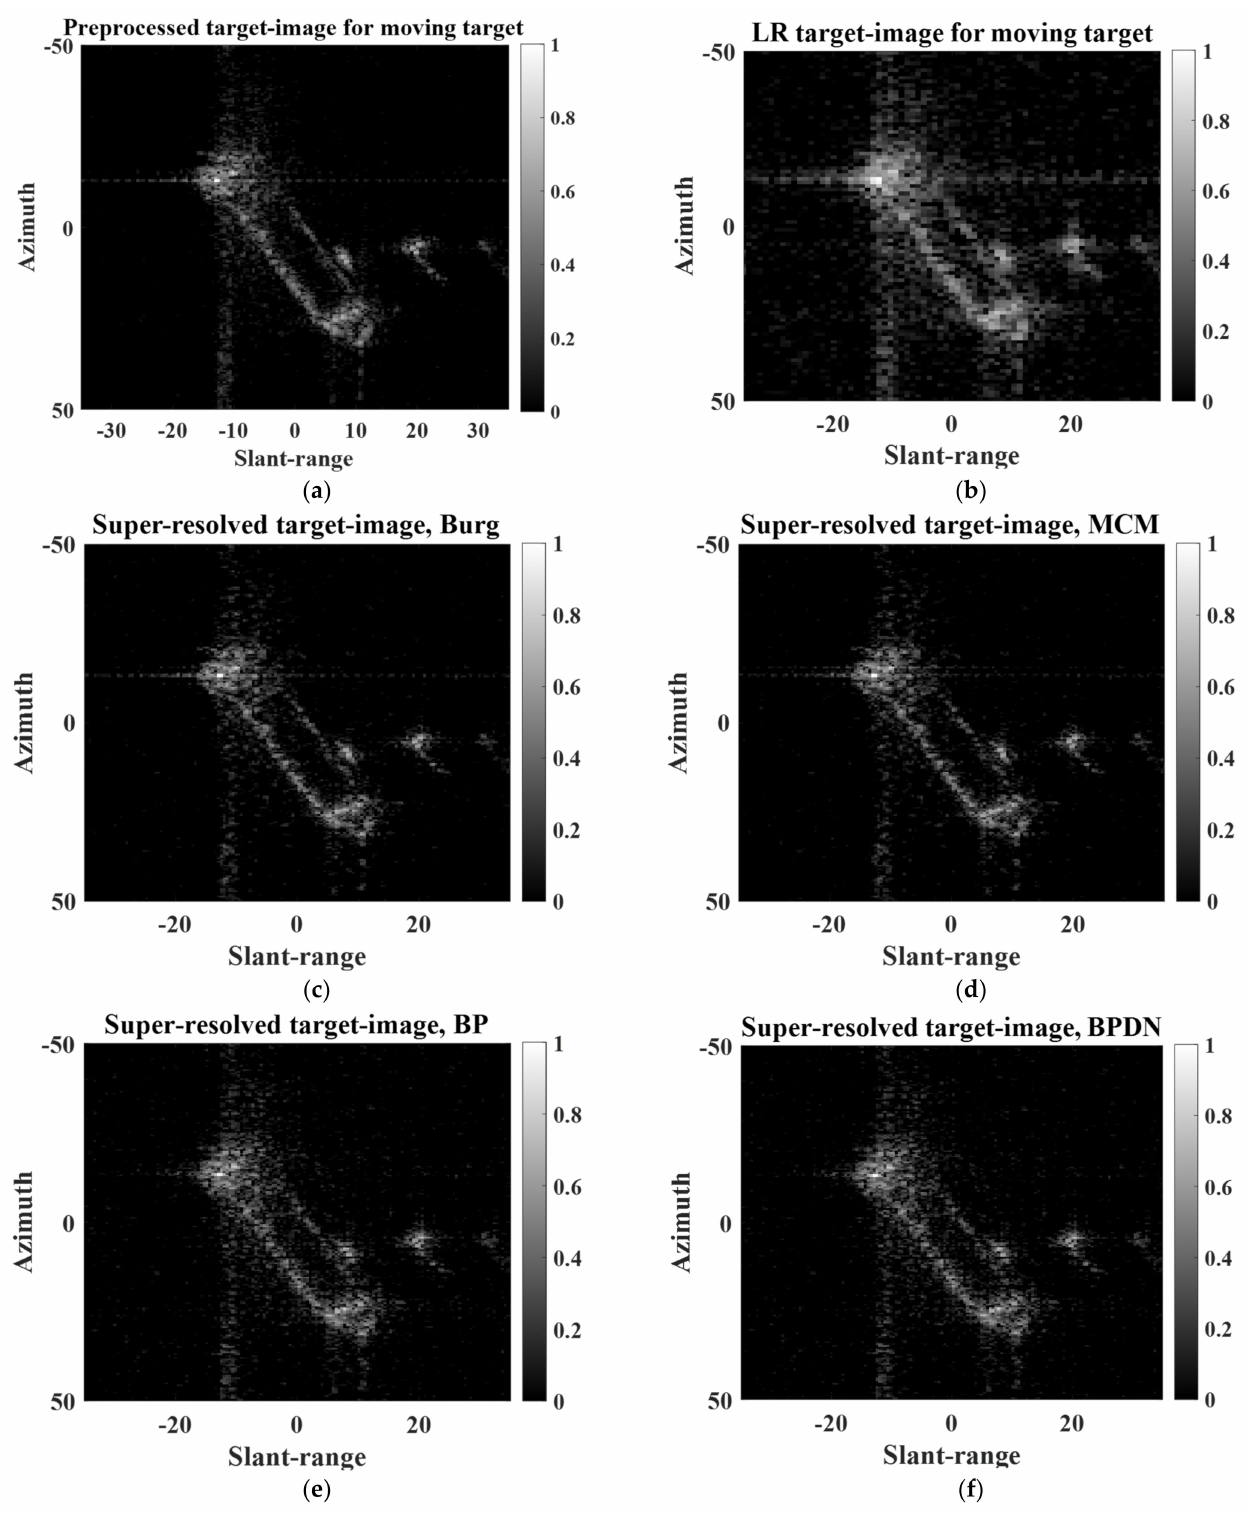
Figure 10. PR, LR, and super-resolved target images of extended moving target: ( a ) PR, ( b ) LR, ( c ) Burg, ( d ) MCM, ( e ) BP, ( f )